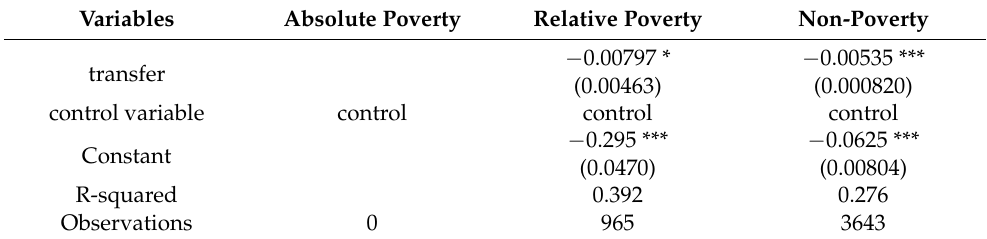
Table 3. Regression results grouped by household poverty level.